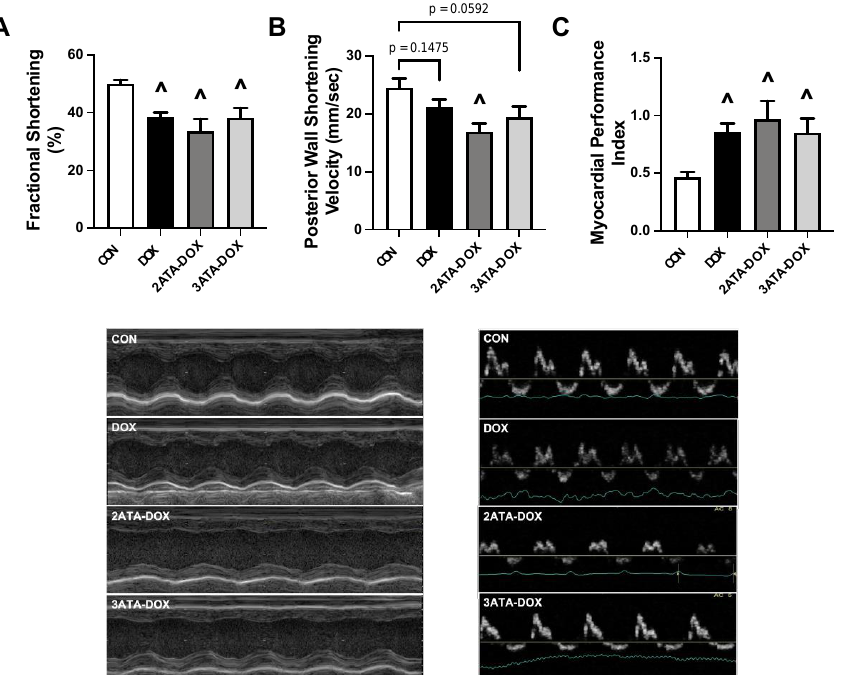
Heart rate (beat per minute (bpm), septal wall thickness during diastole (SWTd), septal wall thick- ness during systole (SWTs), posterior wall thickness during diastole (PWTd) and posterior wall thickness during systole (PWTs) . Values are represented as means ± SEM. ^ = significantly different Figure 3. Cardiac Function . Measurement of ( A ) fractional shortening percentage; ( B ) posterior wall vs. CON ( p < 0.05). shortening velocity (PWSV); and ( C ) myocardial performance index (MPI). Representative images of M-mode ( left ) and Doppler ( right ) are shown below the graphs. Values are represented as means ± SEM. ^ = significantly different vs. CON ( p < 0.05).